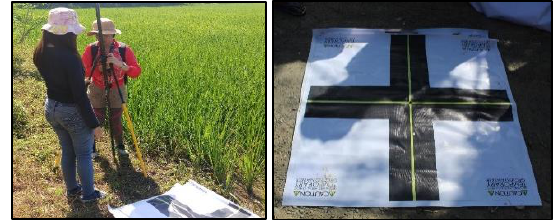
Figure 4. Setting up the GNSS Receiver (left) and actual target on GCP (right)